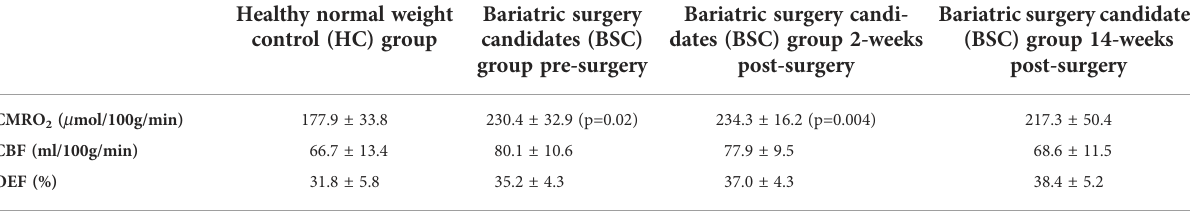
TABLE 2 Global CMRO 2 and the associated global CBF and OEF in HC and BSC groups. Healthy normal weight Bariatric surgery Bariatric surgery candi- Bariatric surgery candidates control (HC) group candidates (BSC) dates (BSC) group 2-weeks (BSC) group 14-weeks group pre-surgery post-surgery